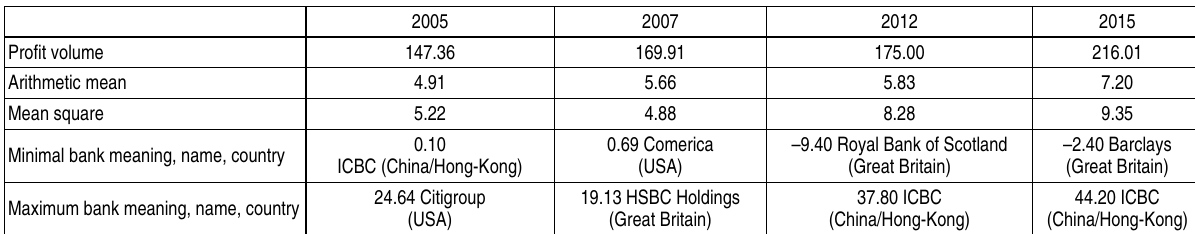
Table 3. The dynamics of profit volume of thirty world major banks, bln US dollars